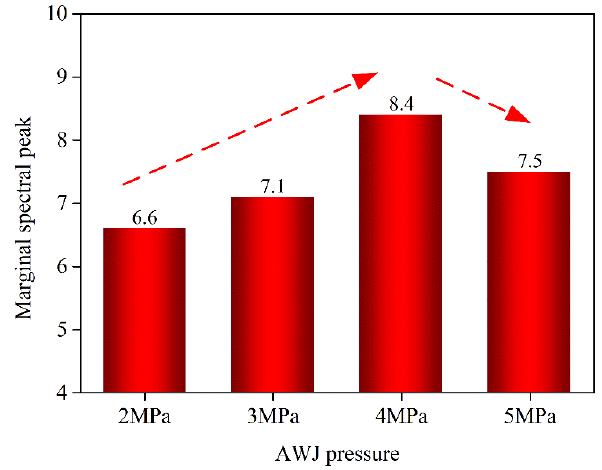
Figure 14. The relationship between the maximum value of the marginal spectrum and the AWJ pressure.